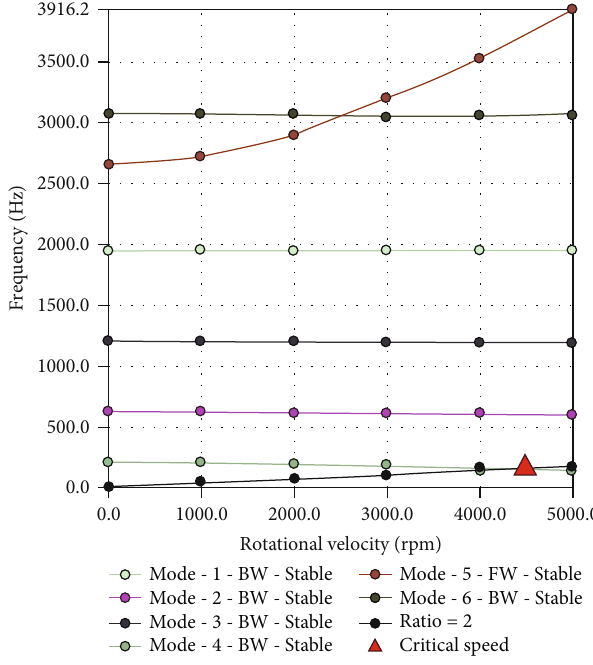
Figure 11: Campbell